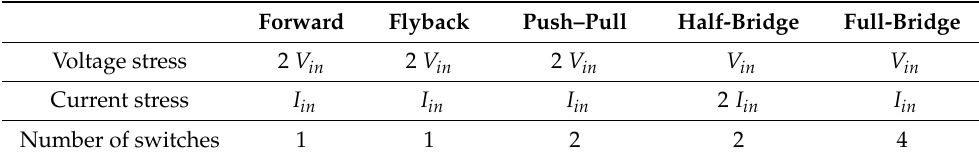
Figure 1. Buck and boost topologies. Table 1. Comparison of isolated topology characteristics.